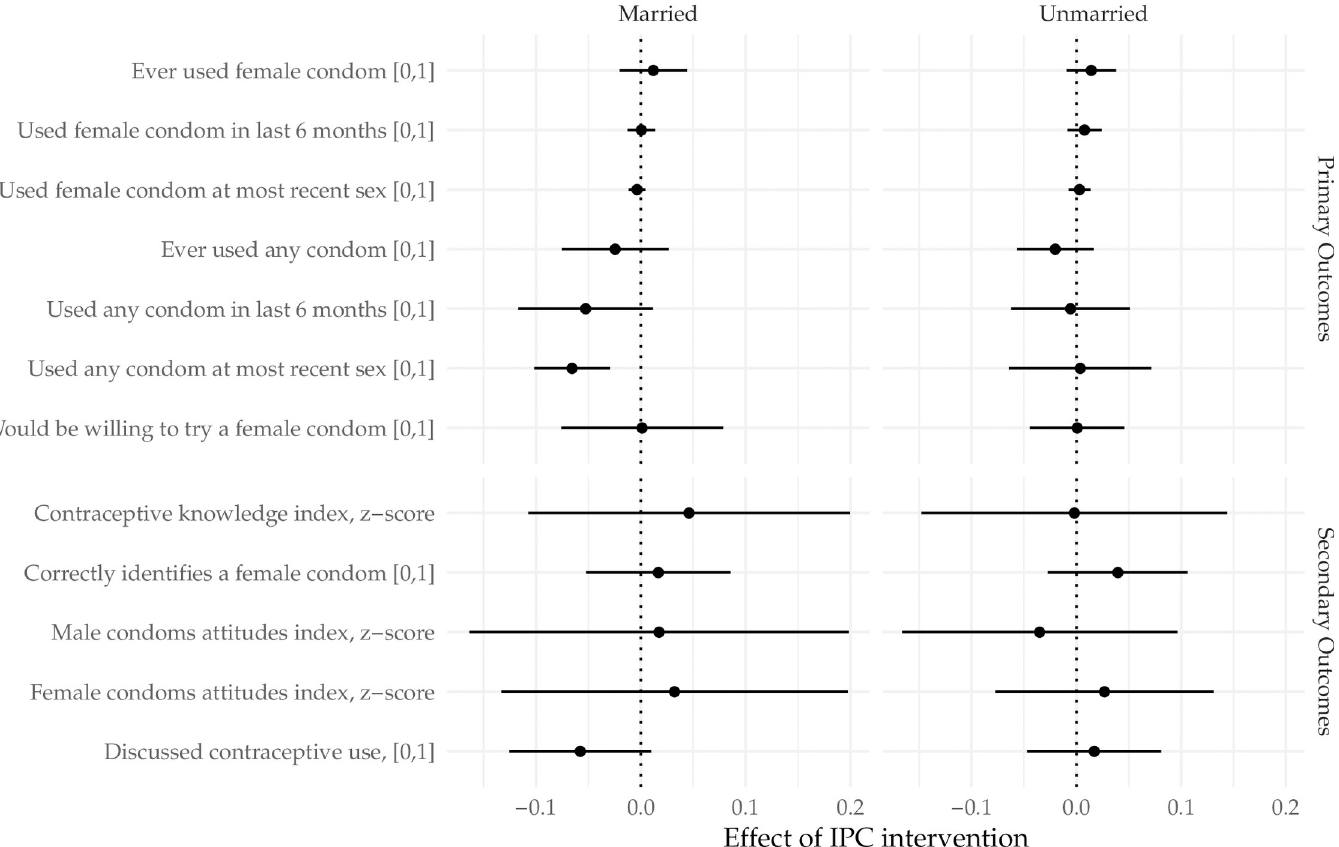
Fig 3. Marital status specific effects of the IPC intervention on key primary and secondary